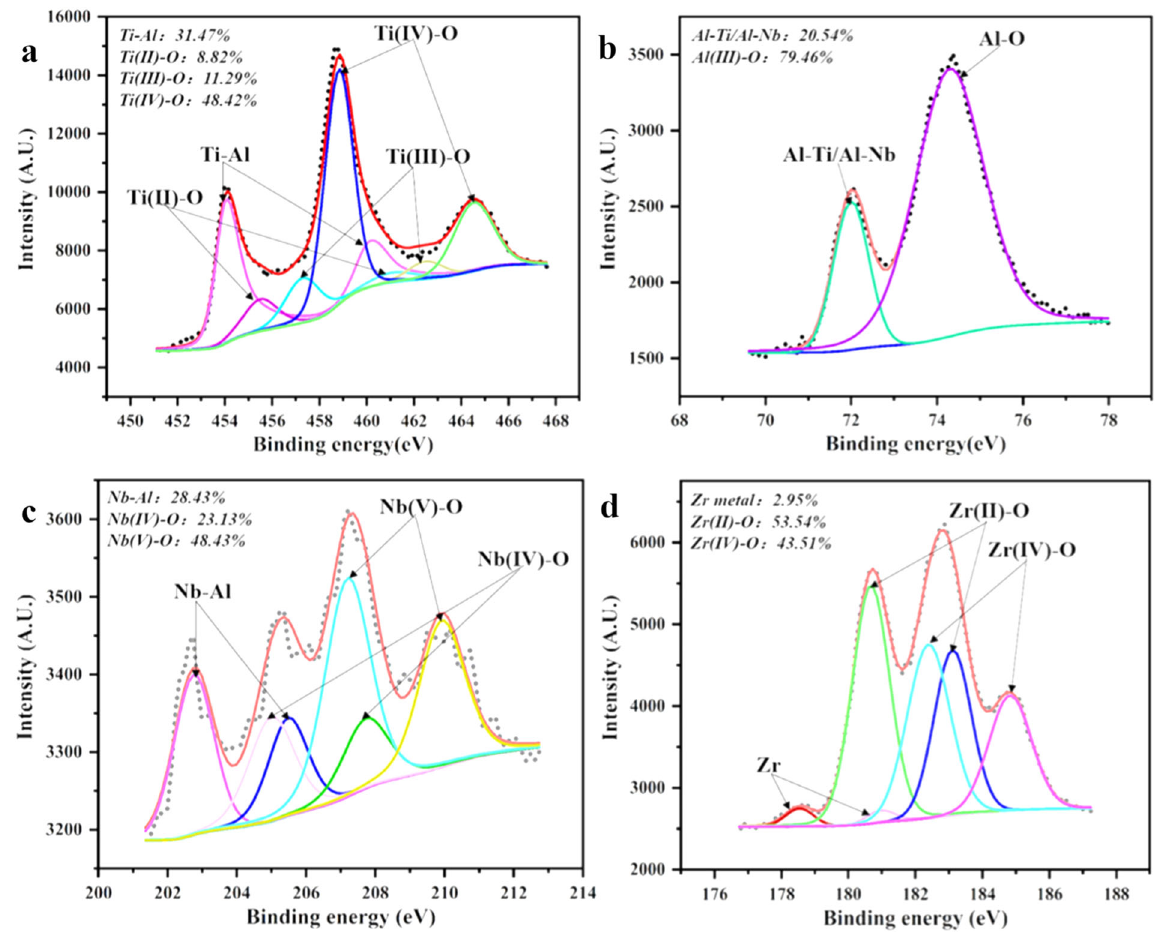
Fig. 2 XPS patterns of PCMM (with 4 wt.% Nano-ZrO 2 addition). a Ti 2p ; b Al 2p ; c Nb 3d ; d Zr 3d